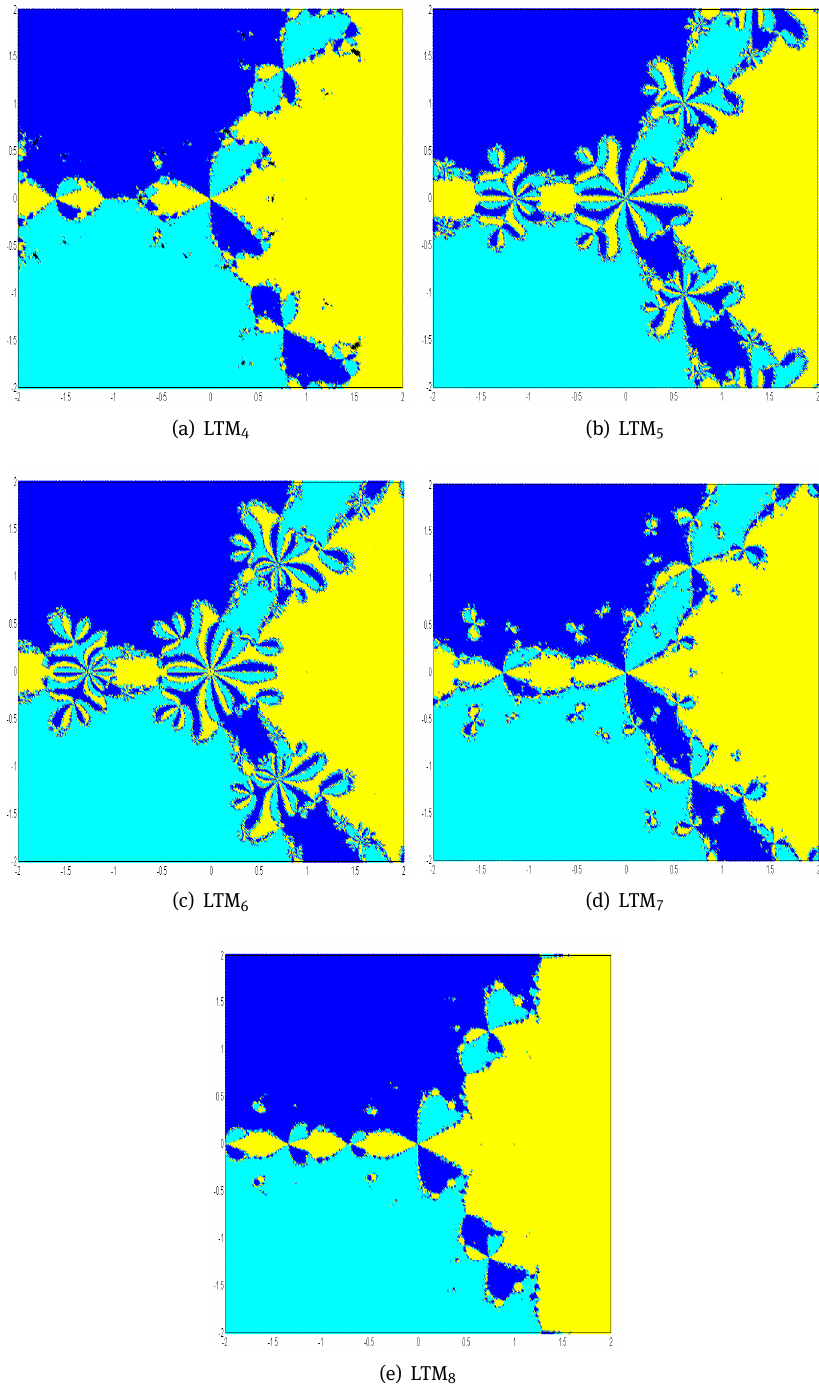
Figure 3: Basins of attraction of the methods LTM 4 , LTM 5 , LTM 6 , LTM 7 and LTM 8 respectively for P 1 ( z ) = z 3 − 1